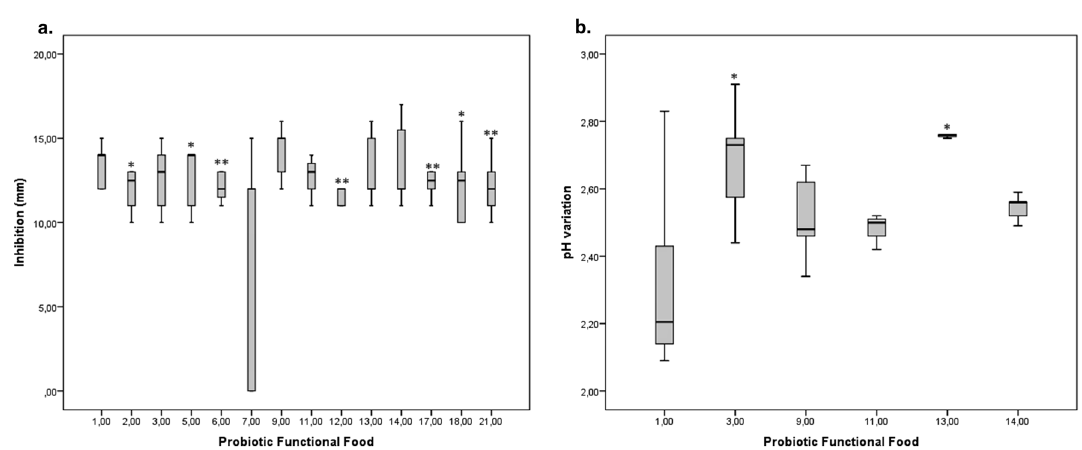
Figure 2. Selection of foods that present the greatest degree of S . mutans growth inhibition and pH reduction. ( a ) Median inhibition compared with food No. 9 which showed the highest median. ( b ) Foods that presented the highest inhibition compared with food No. 1 which presented the lowest median for pH reduction. Mann– Whitney U test, *P < 0.05, **P <